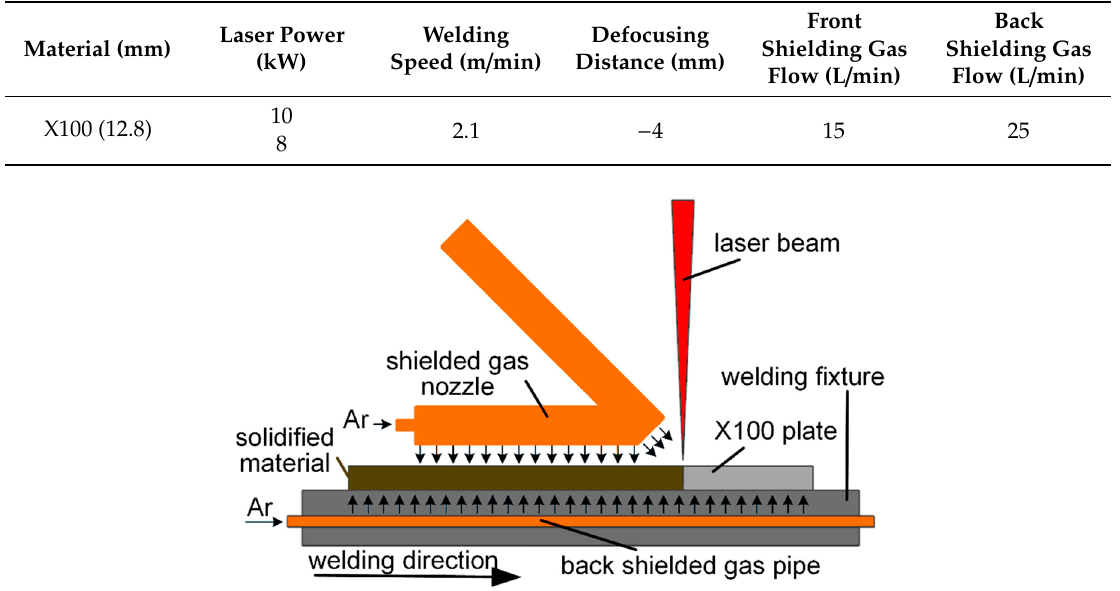
Table 2. Parameters of the X100 pipeline steel laser welding process.